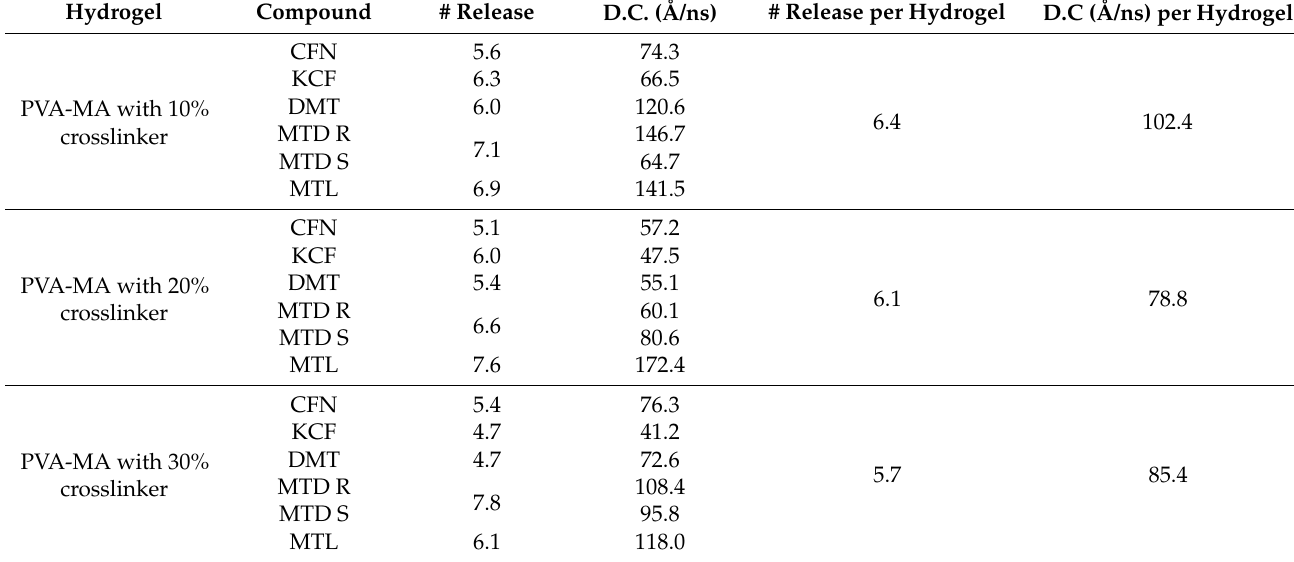
Table 2. Release and diffusion coefficients (D.C.) of selected compounds in PVA-MA systems with different crosslinker ratios. The release of pesticides was calculated during the simulation by counting, in each step, the pesticide molecules located more than 5 Å away from the hydrogel. The release values (# Release and # Release per Hydrogel) correspond to the average of all the